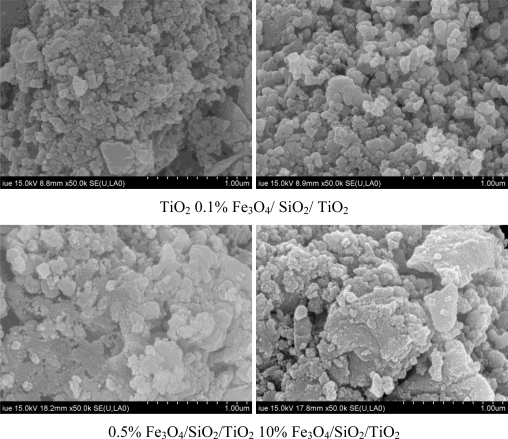
SEM photographs of photocatalysts with different Fe3O4 loadings.